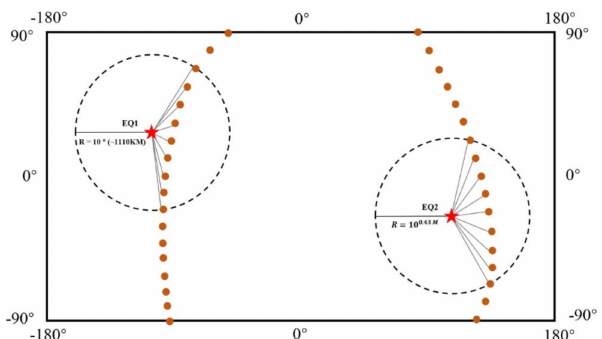
Figure 2. Schematic diagrams showing data points on-orbit (orange dots), at the earthquake epicenter (red stars) and at the areas around the epicenters (dashed circles), which are considered for selecting seismic-related data. The radii of the circles are not at the scale of diagrams. Table 1. Datasets are used as input to the models. Spatial Feature Night / Daytime (with Its Center at the Epicenter and the Temporal Dobrovolsky Radius / a Deviation of 10 ◦ )